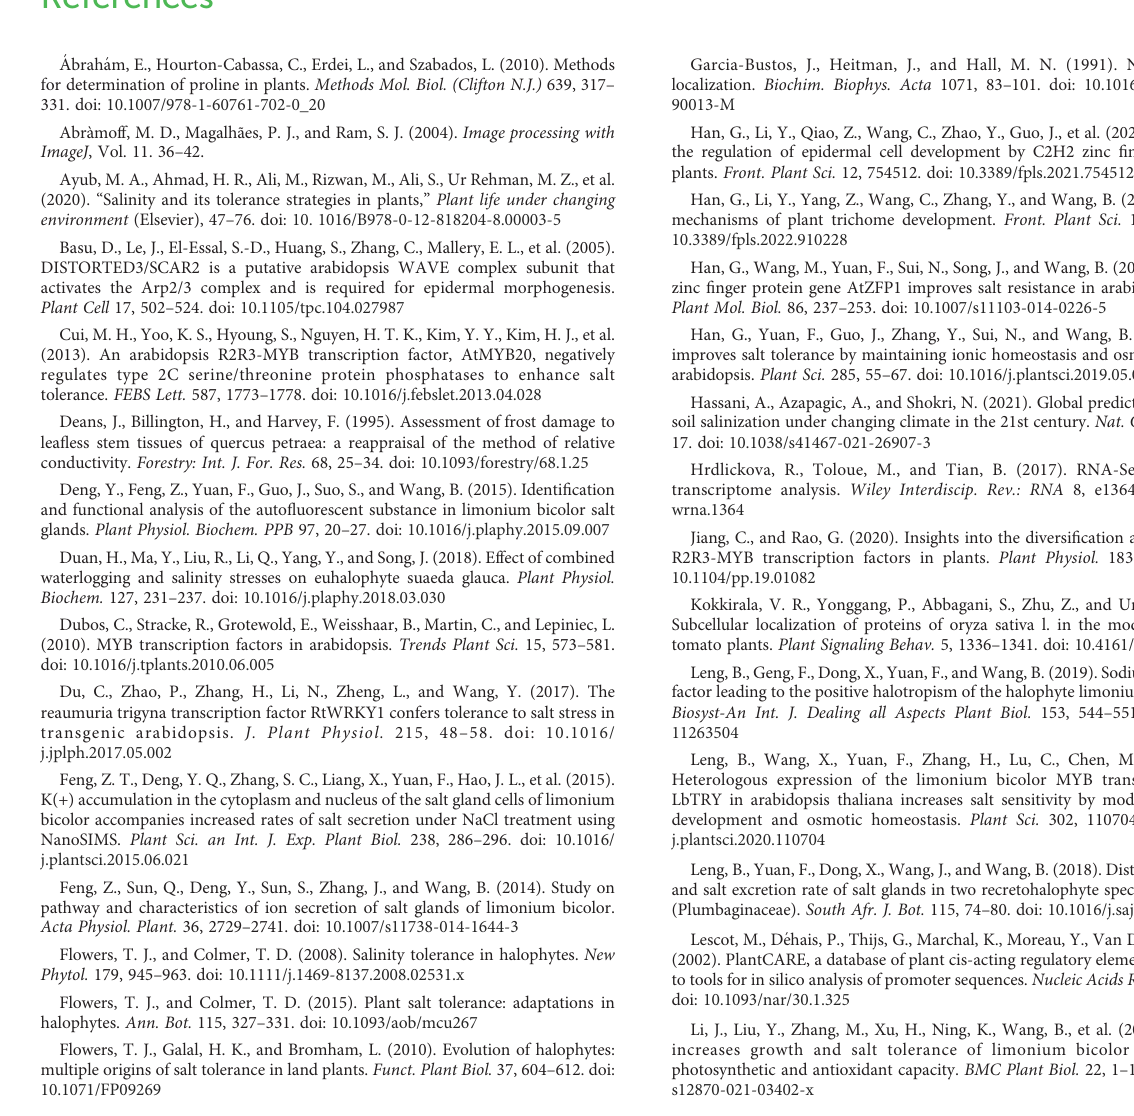
SUPPLEMENTARY FIGURE 4 RT-qPCR validation of differentially expressed genes by RNA-seq. Three replicates should be set up to calculate the standard deviation (SD) and ensure